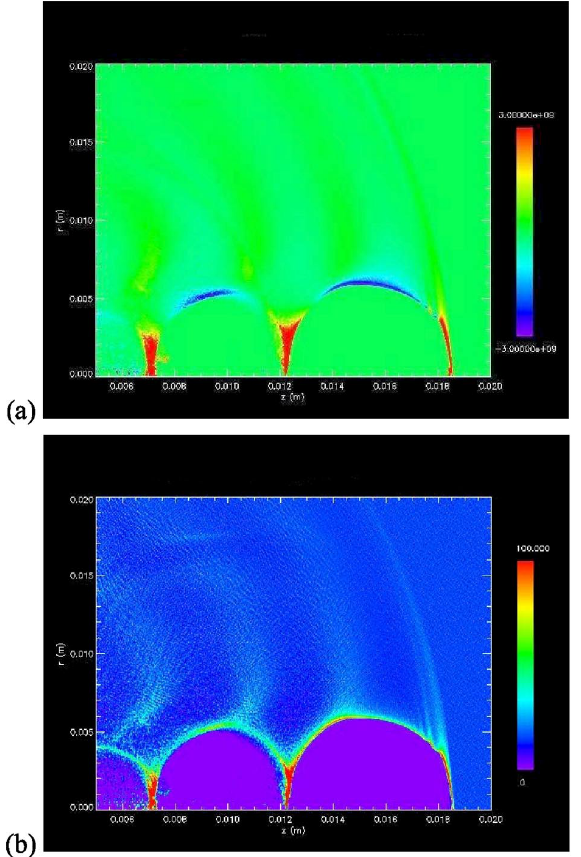
FIG. 3. (Color) OOPIC simulation of the ~ QQ (cid:4) 200 case, drive beam having uniform distribution of width ~ aa (cid:4) 0 : 2 and length ~ ll (cid:4) 0 : 1 . False color (a) plasma longitudinal current density z (color map key on right indicates current density in A = m 2 ) and (b) plasma electron density (color map key on right, ambient level is at 15, indicated in blue).